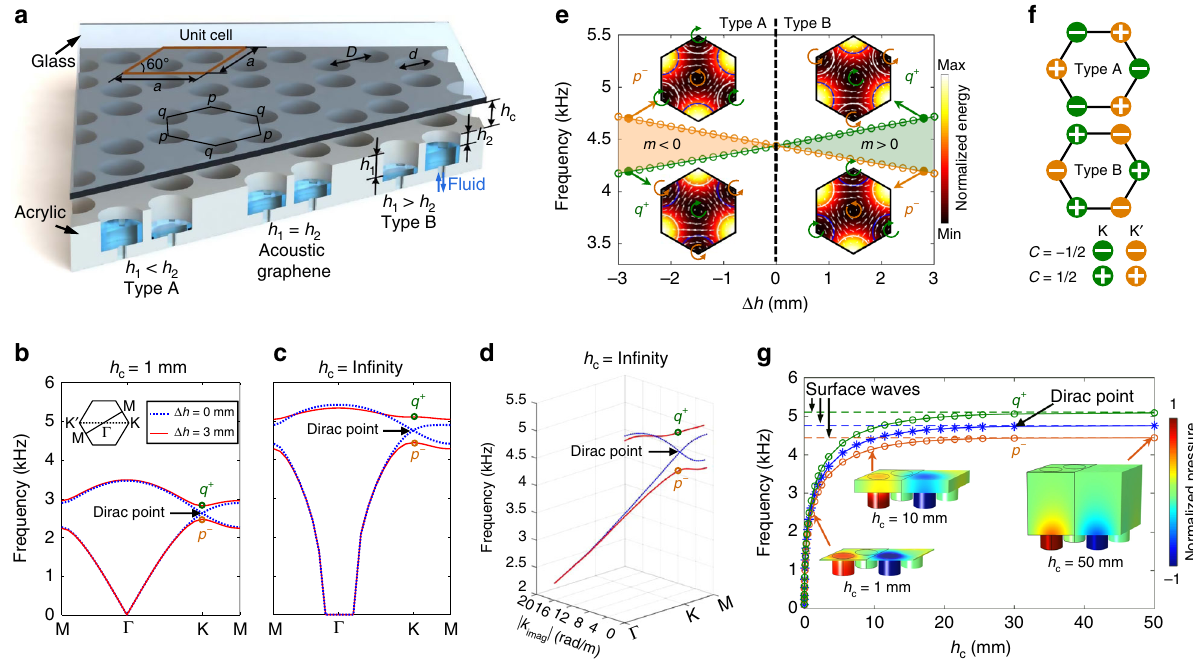
Fig. 1 Schematic of valley topological phononic crystals and their dispersion curves. a Schematic of the phononic crystals (PCs) composed of a glass ceiling and an acrylic plate with cylindrical cavities distributed in honeycomb lattices. The unit cell (marked by a parallelogram) contains two cavities with the same diameter d . The effective depths h 1 and h 2 of cavities can be changed by pumping water into the cavities. When h 1 = h 2 , the PCs are considered as an acoustic analogue of graphene. When h 1 < h 2 and h 1 > h 2 , t h e con fi gurations are denoted as type A and B PCs, respectively. b Dispersion curves for valley PCs, when the channel height h c is 1 mm. Inset: fi rst Brillouin zone (FBZ). Figure b shows a Dirac degeneracy at the K point, when h 1 = h 2 = 11.5 mm. A complete band gap is opened, when Δ h = h 1 − h 2 = 3 mm. c Dispersion curves for valley PCs, when h c = in fi nity. d Three-dimensional (3D) view of dispersion curves in the complex wavenumber – frequency domain. Figure c can be considered as a projection of the 3D view in the real wavenumber part — frequency domain. e Phase diagram revealed by the order of band-edge frequencies locked with speci fi c vortex features (insets), when h The color and white arrows in insets indicate acoustic energy and intensities, respectively. The blue and white arcs represent cavities with depths of 10 and 13 mm. Different acoustic insulating phases are characterized by the signs of the effective mass m . f Theoretical valley Chern numbers for type A and B PCs. g Frequency variations of the Dirac, p − , and q + points with respect to the channel height h c , when the difference Δ h is 3 mm. Insets: pressure fi elds for the p − mode. The q + mode ’ s pressure fi elds are given in Supplementary Fig. 3. The frequencies gradually increase and approach frequencies for surface acoustic waves (SAWs), as h c increases. The evolutions of pressure fi elds and waves frequencies reveal the transition from waveguide acoustic waves to SAWs as the channel height